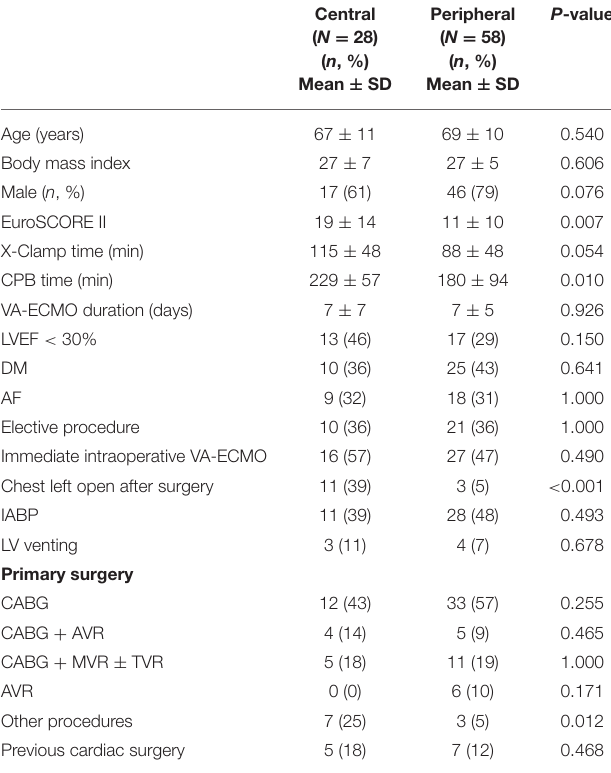
TABLE 1 | Patient characteristics and demographics. TABLE 2 | Outcome after VA-ECMO